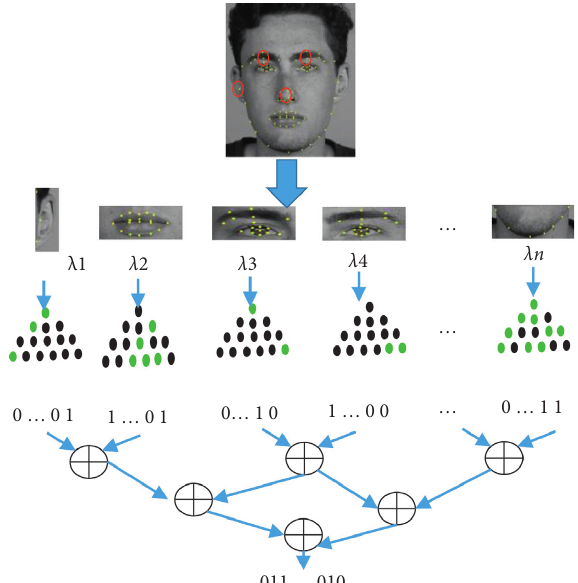
Figure 2: LBF feature extraction